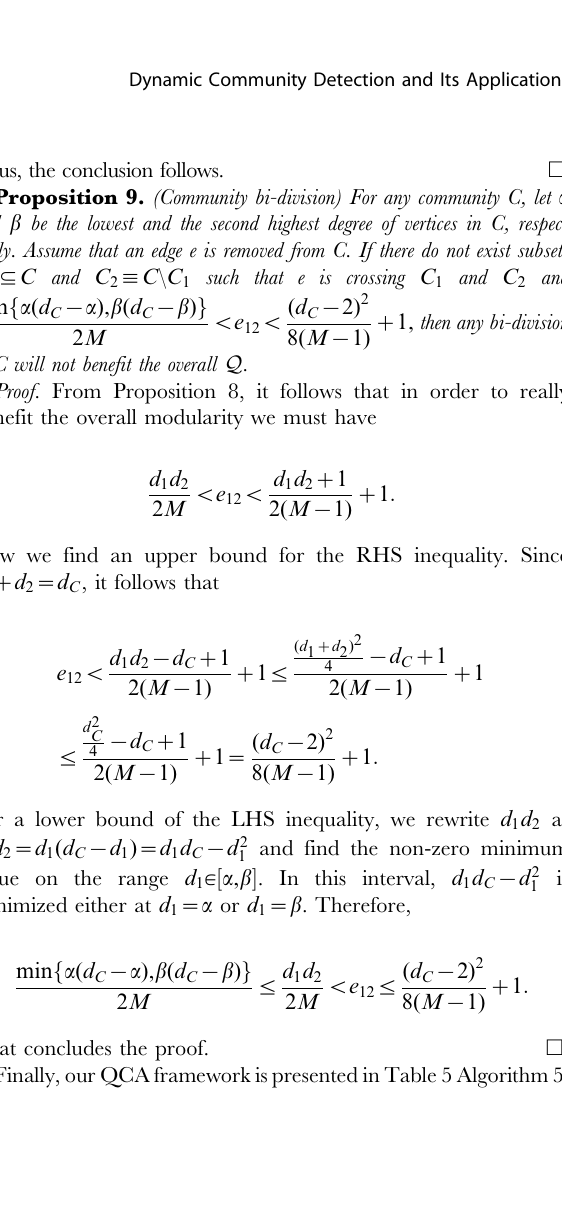
Table 5. Algorithm 5. Q uick C ommunity A daptation (QCA)